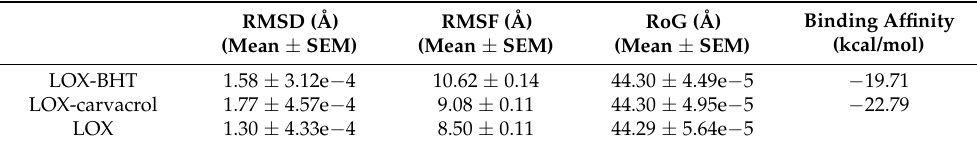
Table 3. Average RMSD, RMSF, and RoG values for LOX in the bound and free state, and binding affinity of docked complexes during molecular dynamics simulation.